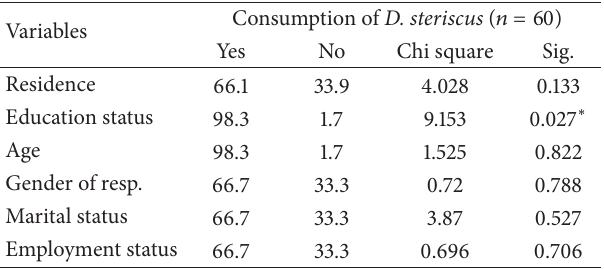
Table 2: Chi square results for dependent variables which would lead to the consumption of D . steriscus in Bindura high density suburbs.